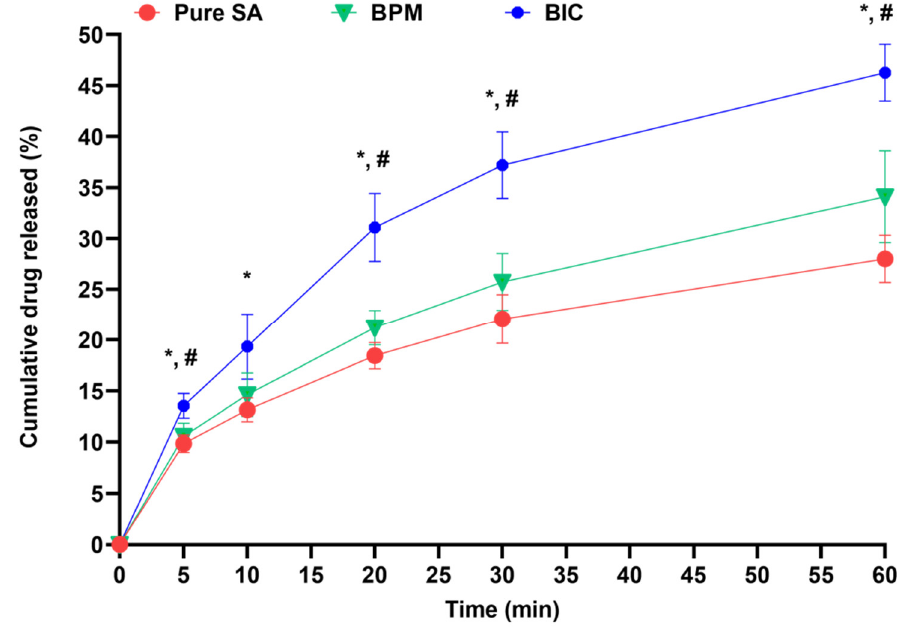
Figure 7. Dissolution profile of SA, BPM, and BIC. * p < 0.05 as compared to SA, # p < 0.05 as compared to BPM.